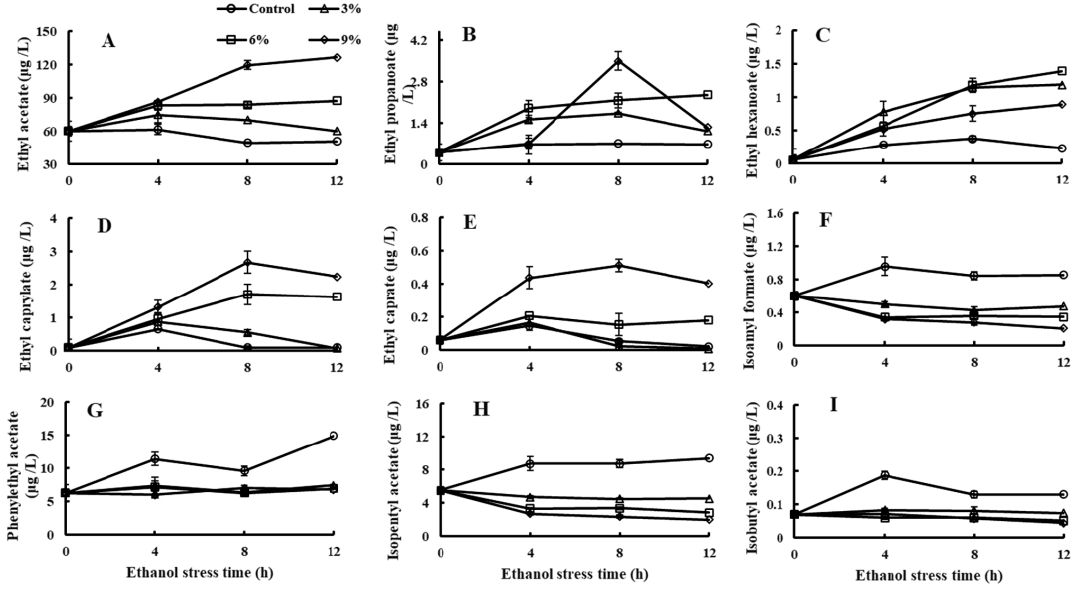
Figure 2. Effects of ethanol stress on the content of ethyl acetate ( A ), ethyl propanoate ( B ), ethyl hexanoate ( C ), ethyl caprylate ( D ), ethyl caprate ( E ), isoamyl formate ( F ), phenylethyl acetate ( G ), isopentyl acetate ( H ) and isobutyl acetate ( I ) of P. anomala NCU003.